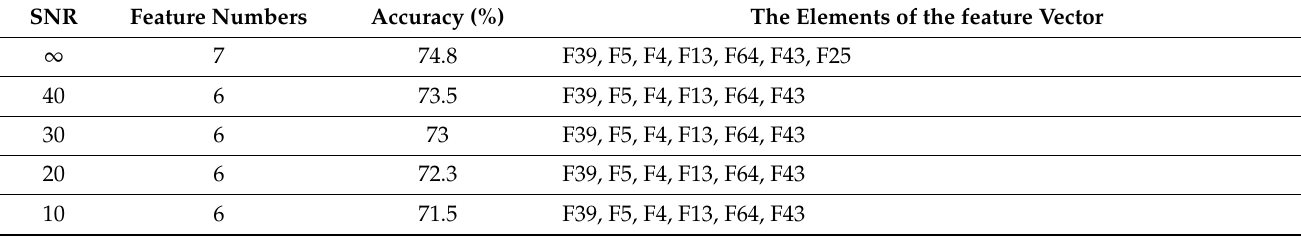
Table 10. Result of the